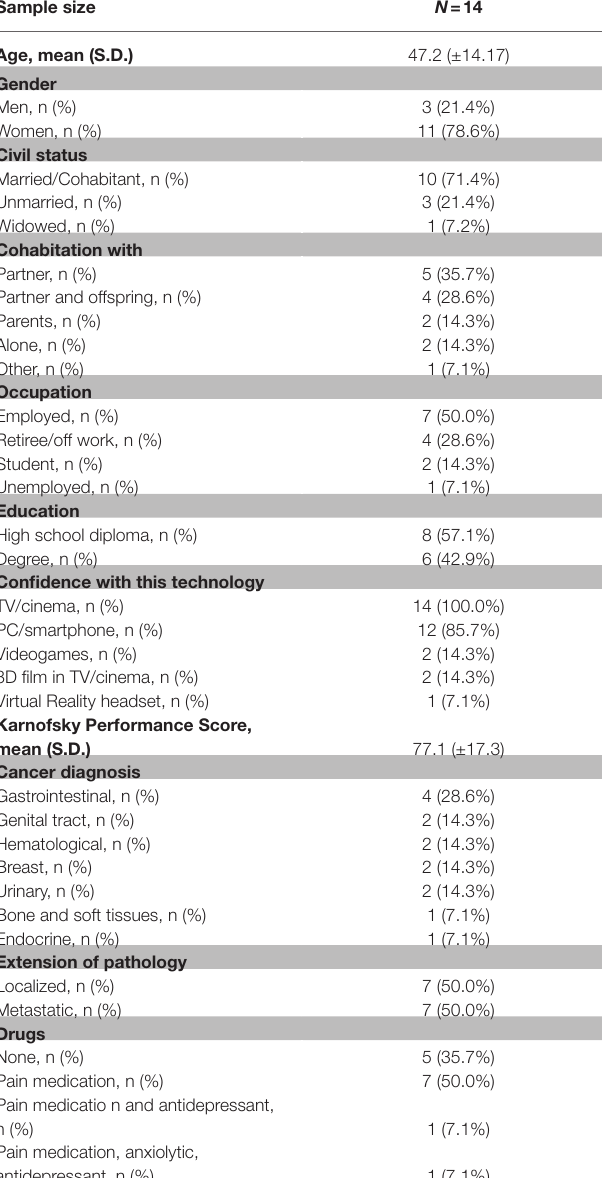
TABLE 1 | Socio-demographic and clinical data of the participants. Sample